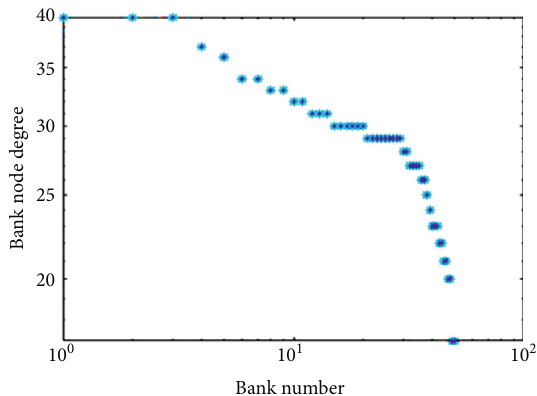
Figure 5: Degree distribution of bank nodes (double logarithmic coordinates).